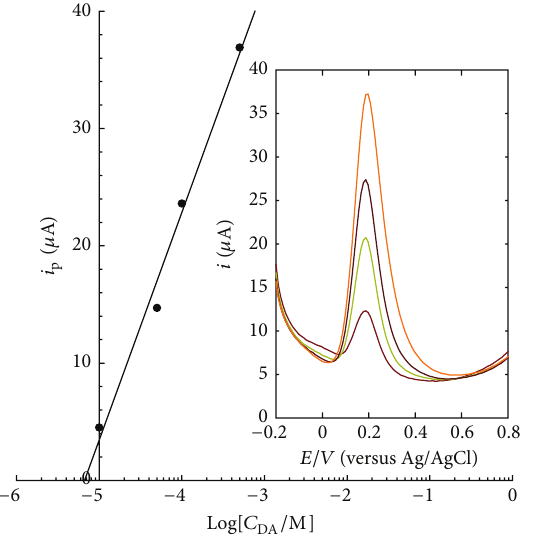
/𝜇 A = 102.2(±6.543)/𝜇 A + 19.39 Figure 9: Calibration curve {𝑖 p (±1.560) log ([ DA ]/ M ) , 𝑟 2 = 0.997} obtained from variation of the SWVanodicpeakcurrentasafunctionofDAconcentrationinstan- dard addition solutions. Inset shows square wave voltammograms obtained on the MCPE/MNP in 5.0 × 10 −6 M DOPADIC solution prepared by standard addition method, inner to outer; 1.0 × 10 −5 , 5.0×10 −5 , 1.0×10 −4 , and 5.0×10 −4 M DA. Conditions are the same as in Figure